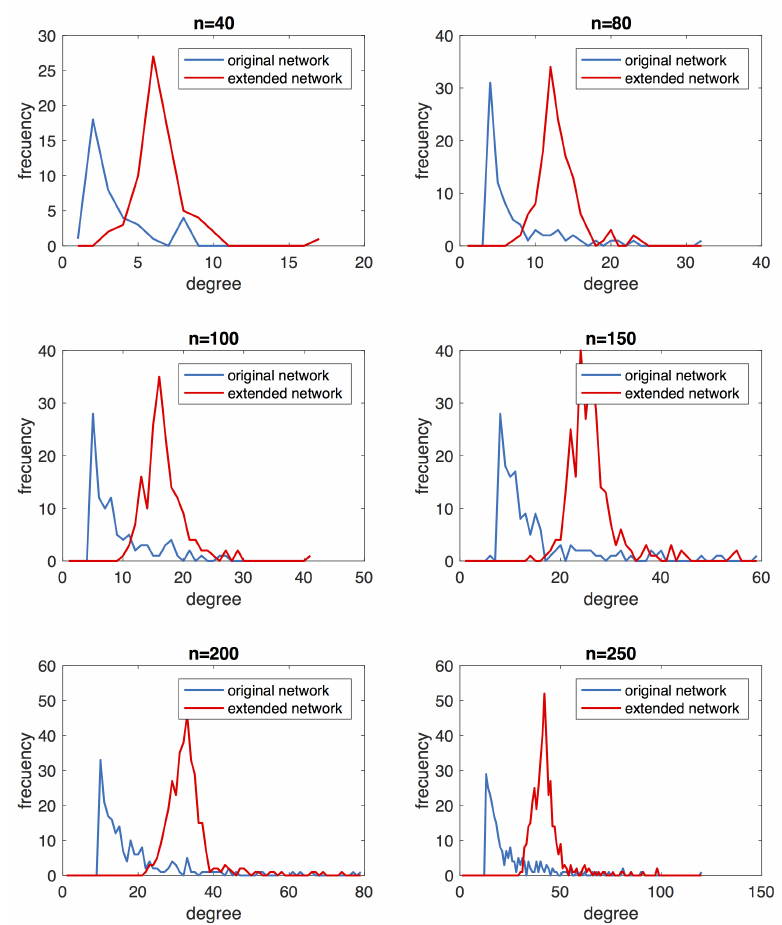
Fig. 4. Frequency plots for point degree with 75% of nodes added